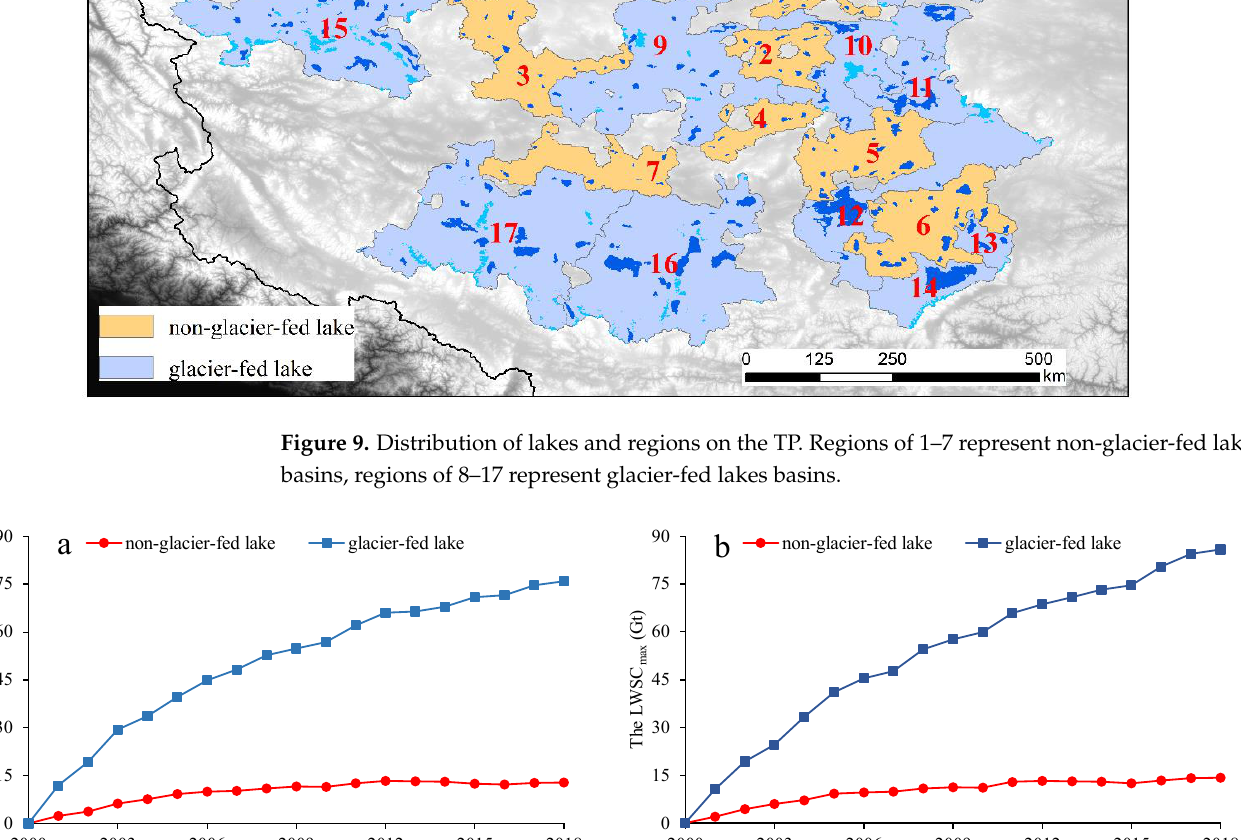
Figure 10. The LWSC of non-glacier-fed lakes and glacier-fed lakes during 2000–2018. ( a ) The changing trend of LWSC min ; ( b ) The changing trend of LWSC max .